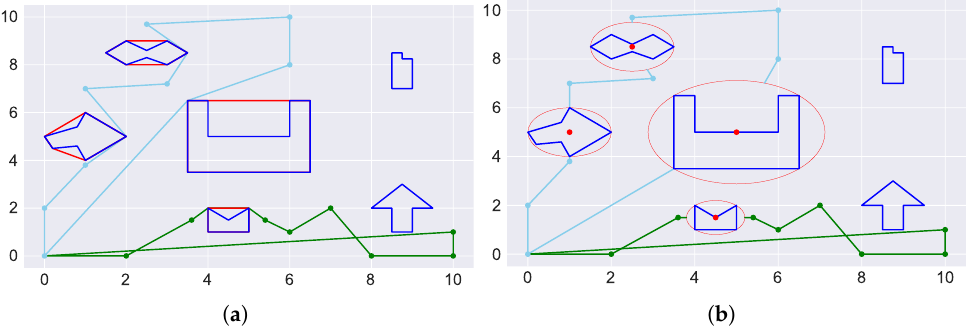
Figure 7. Trajectories of the UAVs. ( a ) Trajectory obtained by GA w/VRAOA. ( b ) Trajectory obtained by GA